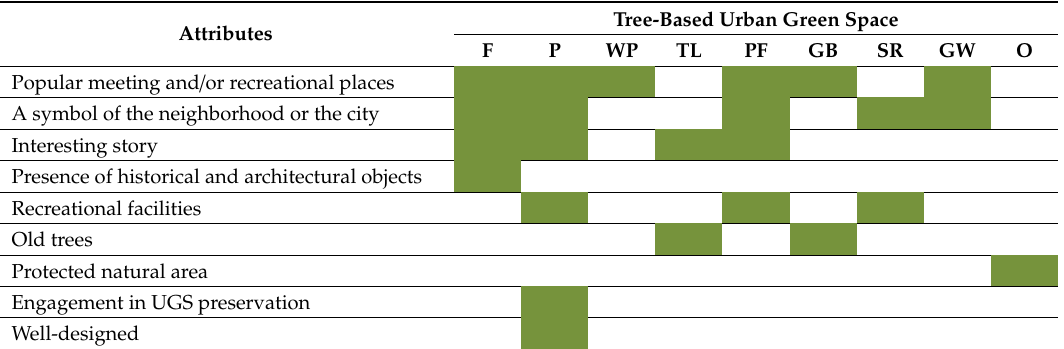
Table 6. Cultural identity of tree-based urban green space (UGS). Green indicates the assignation of attributes to particular type of UGS (F—forest, P—park, WP—walking paths along the streams, TL—tree lines, PF—park forest, GB—greenery around residential buildings, SR—greenery of sports and recreational facilities, GW—greenway,